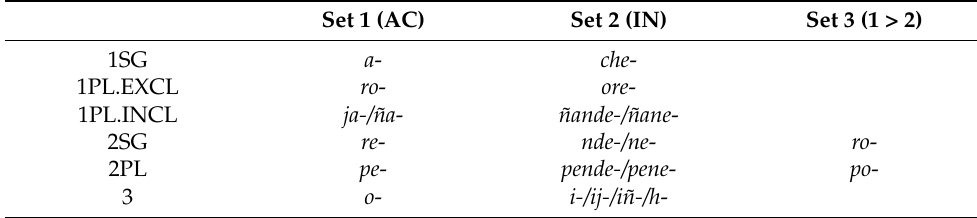
Table 1. Mbya Guarani argument indexation system. Set 1 (AC) Set 2 (IN) Set 3 (1 > 2) 1SG a